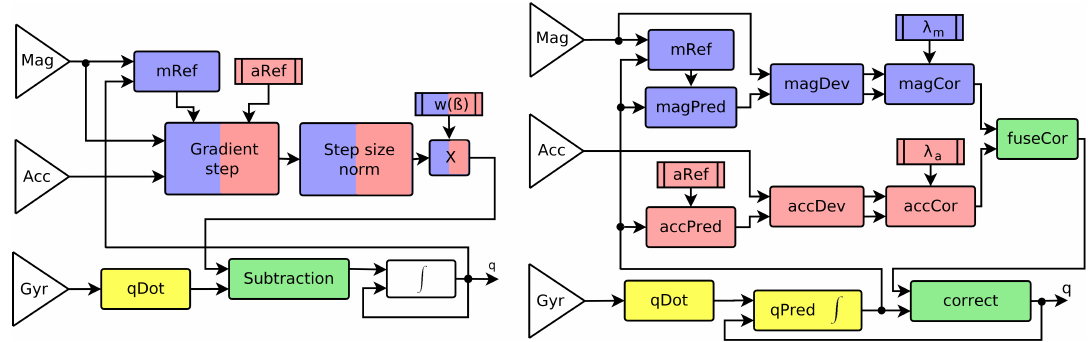
Figure 1. Block diagram of the Madgwick magnetic angular rate and gravity sensor combination (MARG) filter ( left ) and the proposed separated correction filter (SCF) ( right ). Yellow blocks denote prediction from the gyroscope; Blue blocks denote correction from the magnetometer; Red blocks the accelerometer correction, and Green is fusion of the correction steps and its application to the predicted values. Detailed description of blocks of the proposed filter is provided in Section 3, namely Section 3.1 (qDot), Section 3.2 (qPred), Section 3.3 (aRef, accPred), Section 3.4 (mRef, magPred), Section 3.5 (magDev, accDev), Section 3.6 (magCor, accCor), Section 3.7 (fuseCor), and Section 3.8 (correct). Tuning parameters of the proposed filter are λ m and λ a